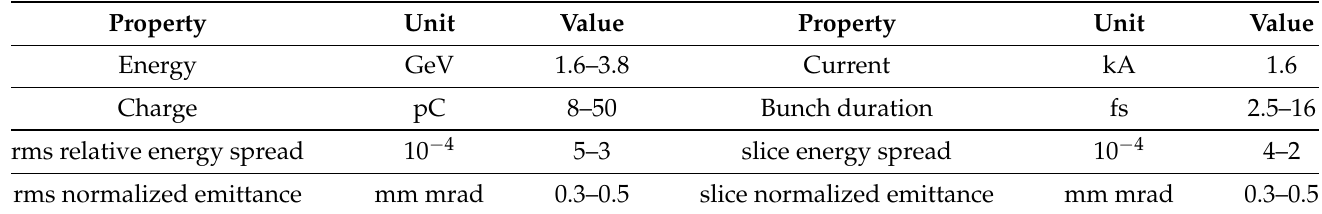
Table 1. Electron beam for MariX FEL.